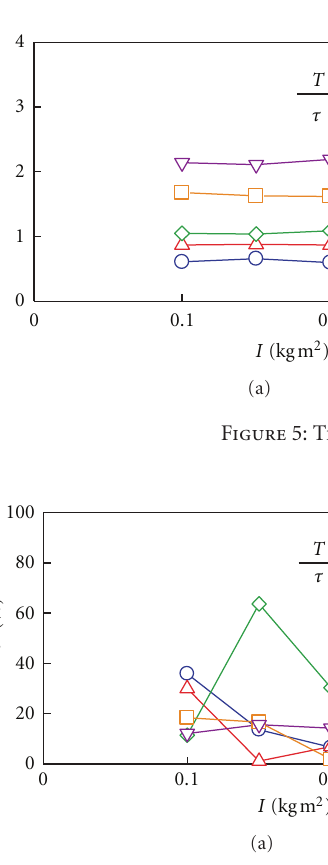
Figure 6: Experimental error of time delay for wind amplitude (a) Δ V = 1 and (b) Δ V =